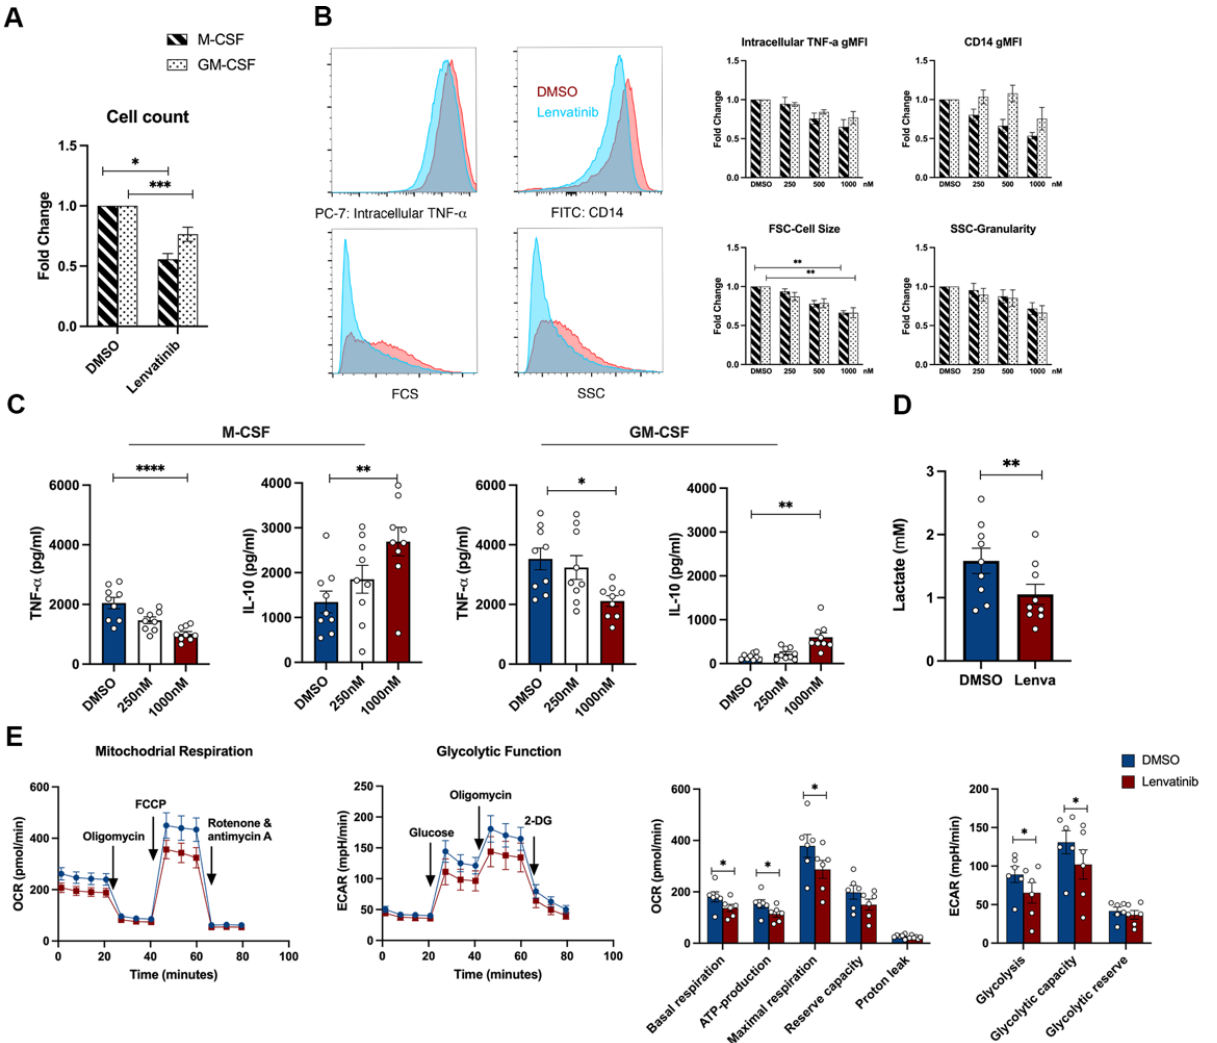
Figure 4. Morphological, functional, and metabolic changes in Lenvatinib-treated macrophages. ( A ) Overall macrophage survival determined by flowcytometry; the cell counts of macrophages were gated on FCS-A and SSC-A (n = 11). ( B ) Left panel indicates representative histogram of the parameters, including intracellular TNF, CD14 expression, cell size (FSC), and granularity (SSC), analyzed by flowcytometry from one donor. The right panel shows the corresponding quantification of gMFI, n = 6. ( C ) Cytokine production from GM-CSF/M-CSF primed macrophages, n = 9. ( D ) Lactate production from GM-CSF-induced macrophages after 24h of stimulation with LPS, n = 6. ( E ) Analysis of ECAR and OCR from GM-CSF-polarized macrophages was performed with a seahorse XF analyzer. The left figure shows the OCR and ECAR profiles for macrophages exposed to Lenvatinib or DMSO vehicle control. The right figure shows mitochondrial bioenergetic and glycolytic parameters calculated from OCR and ECAR (n = 6). The bar graphs indicate mean ± SME; each dot represents one healthy donor. * p < 0.05, ** p < 0.01, *** p < 0.001, **** p < 0.0001 by nonparametric Wilcoxon matched-pair tests. FSC, forward scatter; ECAR, extracellular acidification rate; OCR, oxygen consumption rate; SSC, side scatter.